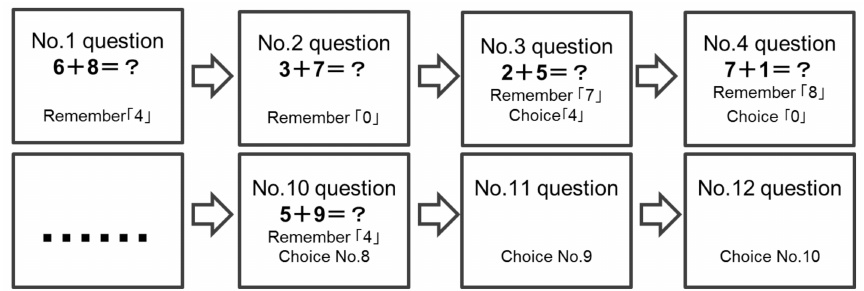
Figure 1. Methodology of the 2-back test, in which a sequence of 12 questions was presented. Partici- pants were required to remember the last number of the previous result for each trial. Subsequently, the last number of the result from the two previous trials in the sequence was reported, and the reaction time and accuracy were